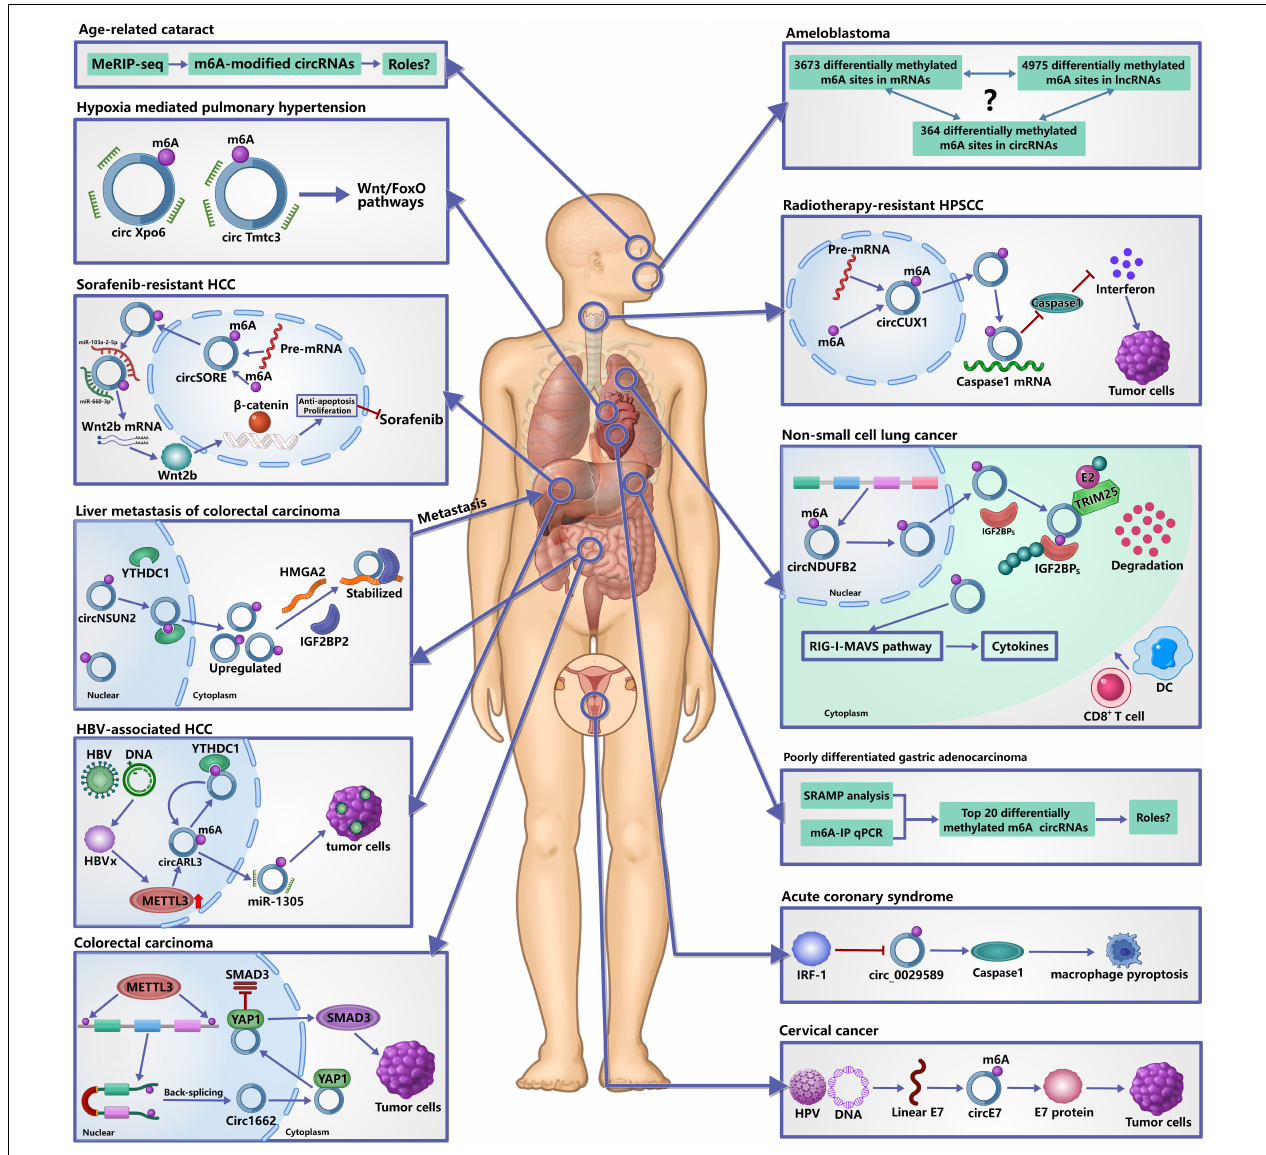
FIGURE 3 | Roles of m6A-modified circRNAs in diseases. It has confirmed that m6A modification of circRNAs plays important roles in the occurrence and development of human diseases. In tumors, m6A-modified circRNAs are not only involved in their occurrence, development and metastasis, but also in the resistance of chemotherapy and radiotherapy by regulating the metabolism and functions of circRNAs. In acute coronary syndrome, IRF-1 facilitates macrophage pyroptosis and inflammation by inhibiting m6A-modified circ_0029589, thereby promoting the formation of necrotic core. In hypoxia mediated pulmonary hypertension, m6A may affect the interaction between circRNAs and miRNAs to participate in its development. In age-related cataract, many differentially expressed m6A-modified circRNAs are identified, but the specific roles remain